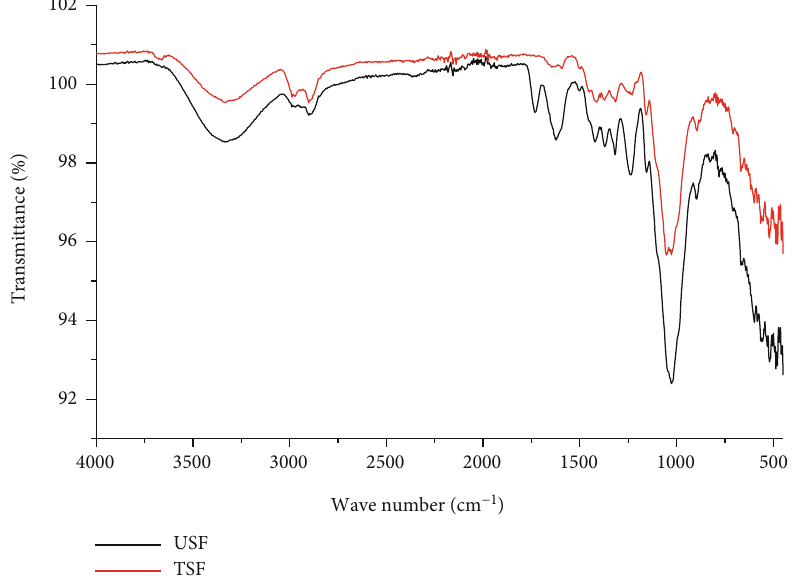
Figure 3: FTIR spectra of untreated and treated sisal fi